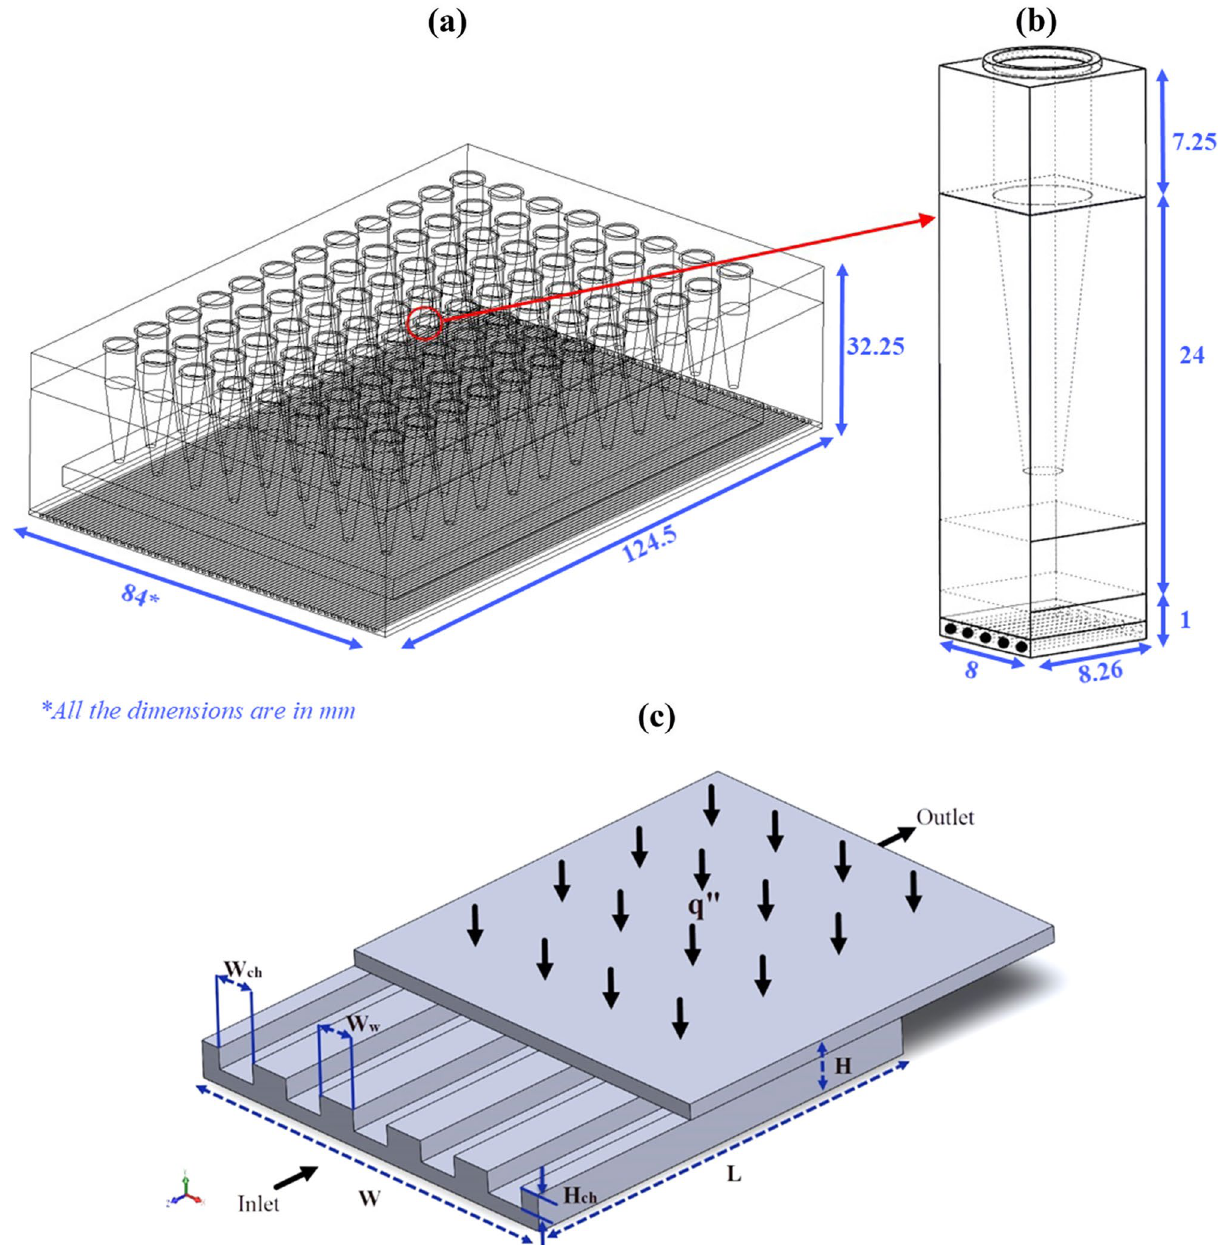
Figure 1. Schematic of ( a ) whole structure of 96 well PCR plate with a microchannel attached to the bottom of the apparatus ( b ) single structure of PCR device and PCR plate with a microchannel attached to the bottom surface, ( c ) microchannel heatsink.